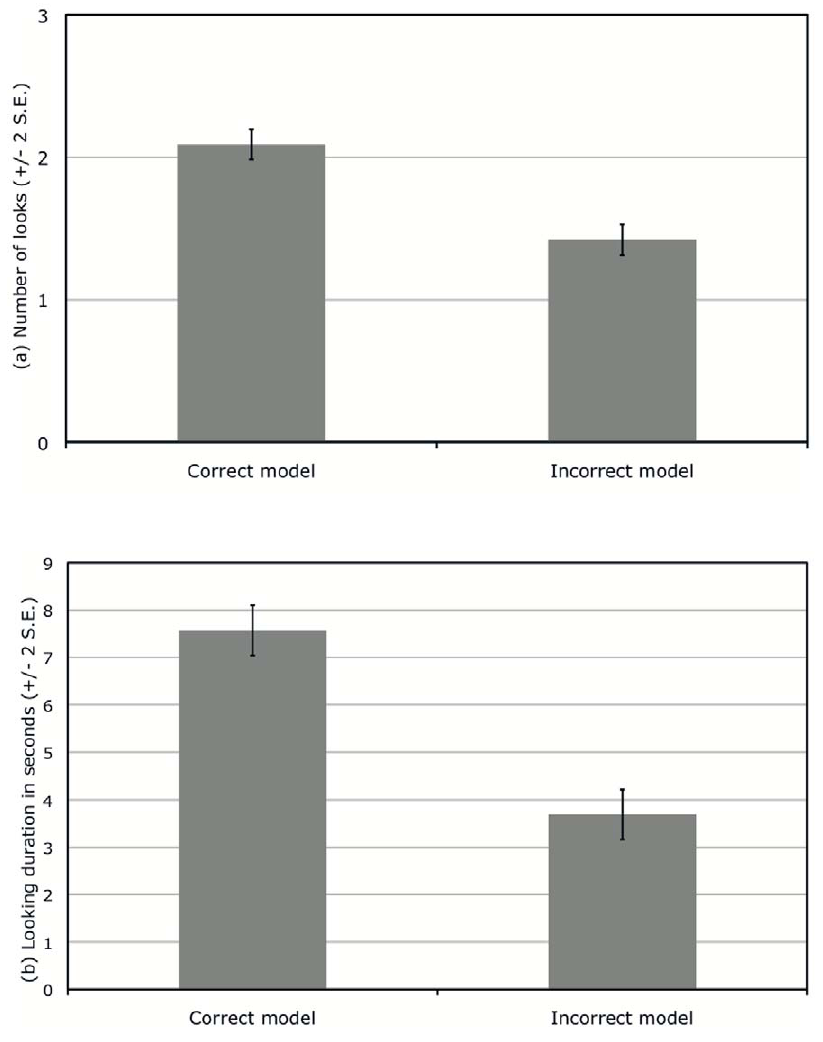
Figure 1. Number of looks (a) and looking duration (b) at the correct and incorrect models.